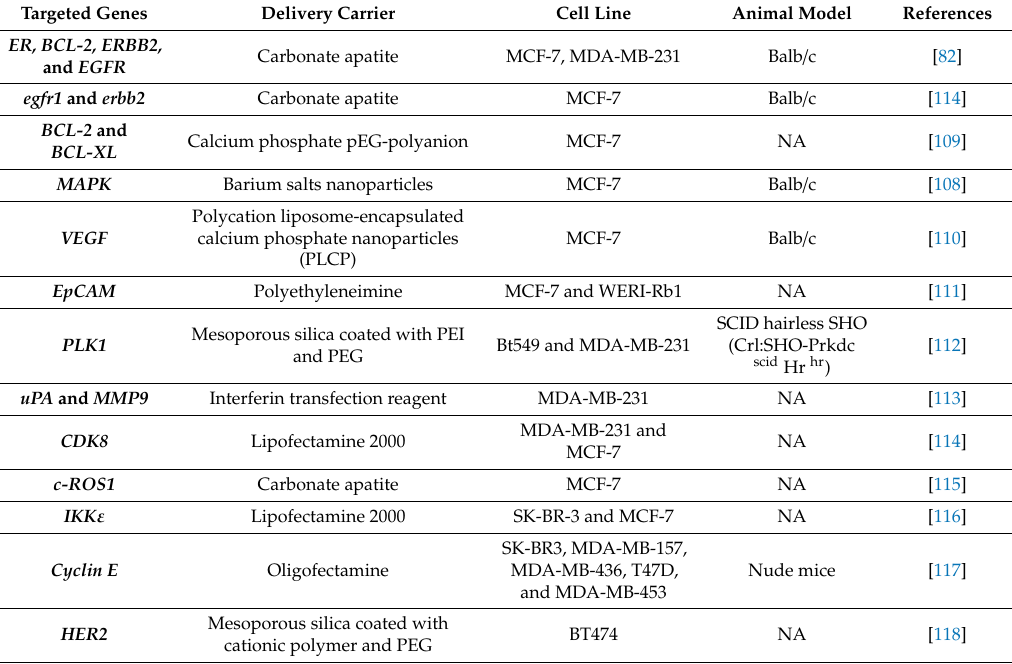
Table 1. List of targeted genes for siRNA knockdown in breast